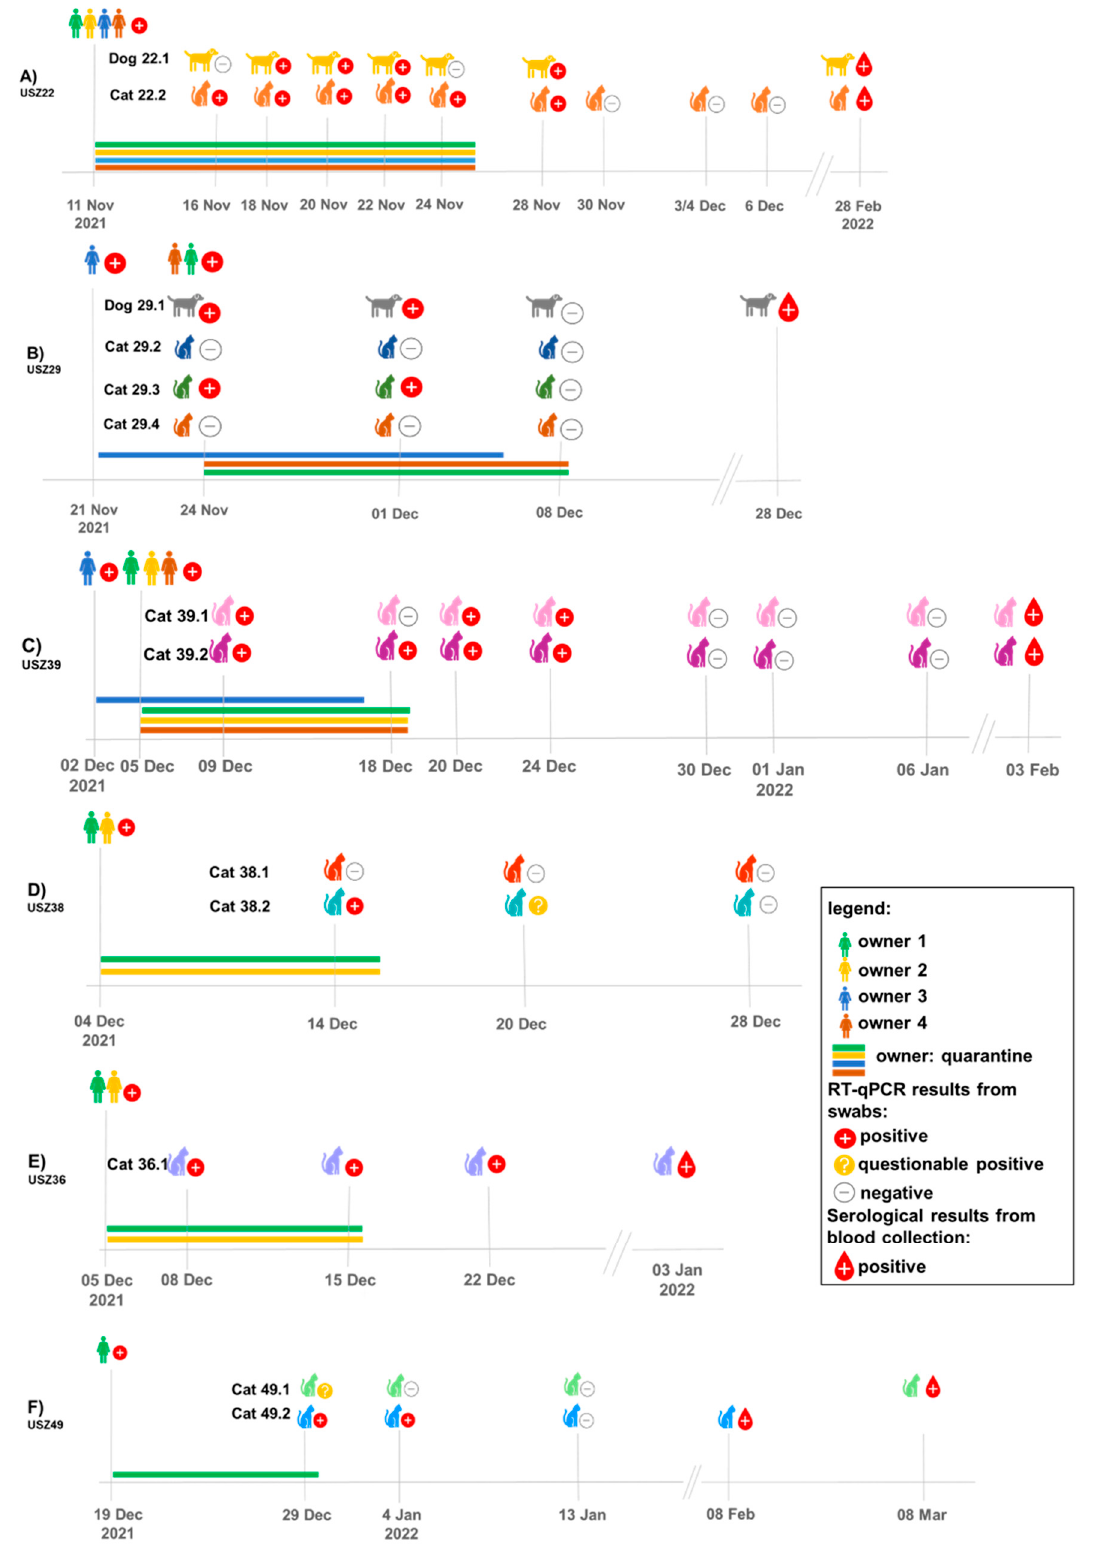
Figure 1. Overview of testing and results (RT-qPCR and serology samples) of animals and owners in households USZ22 ( A ); USZ29 ( B ); USZ39 ( C ); USZ38 ( D ); USZ36 ( E ); and USZ49 ( F ). Only owners that tested positive are shown. All households shown are located in the canton of Zurich.